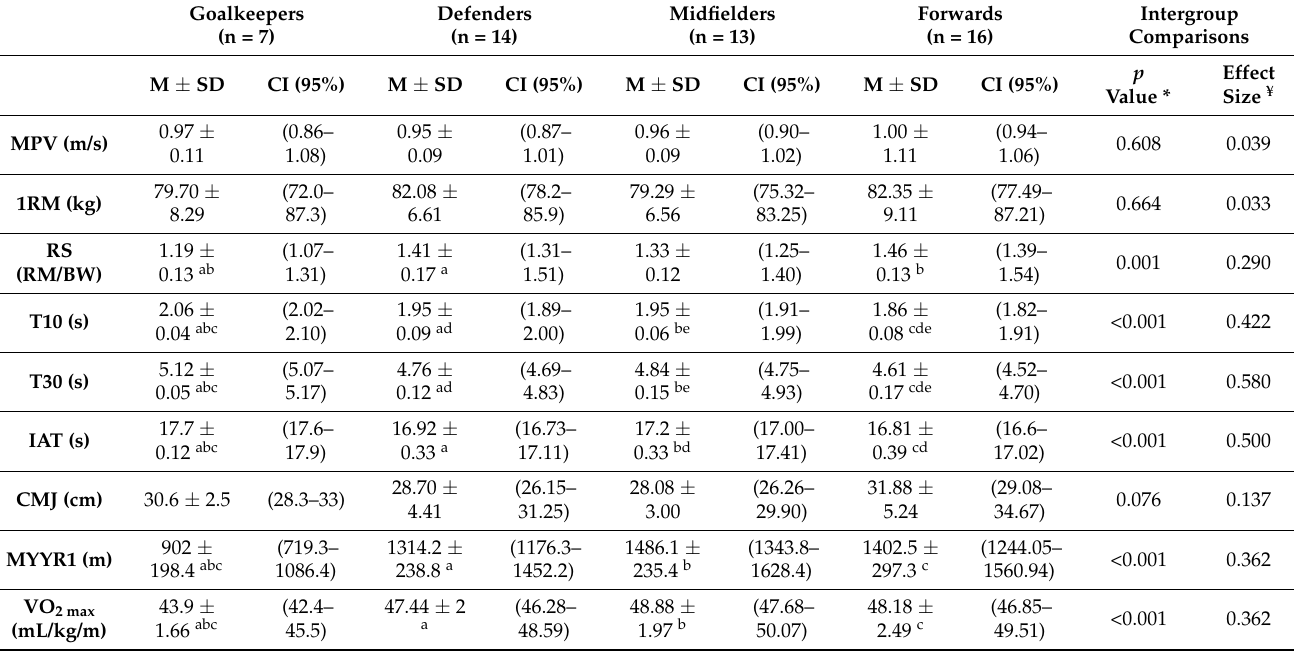
Table 2. Physical fitness variables by playing positions. Mean ± standard deviation (M ± SD) and 95% confidence interval (CI